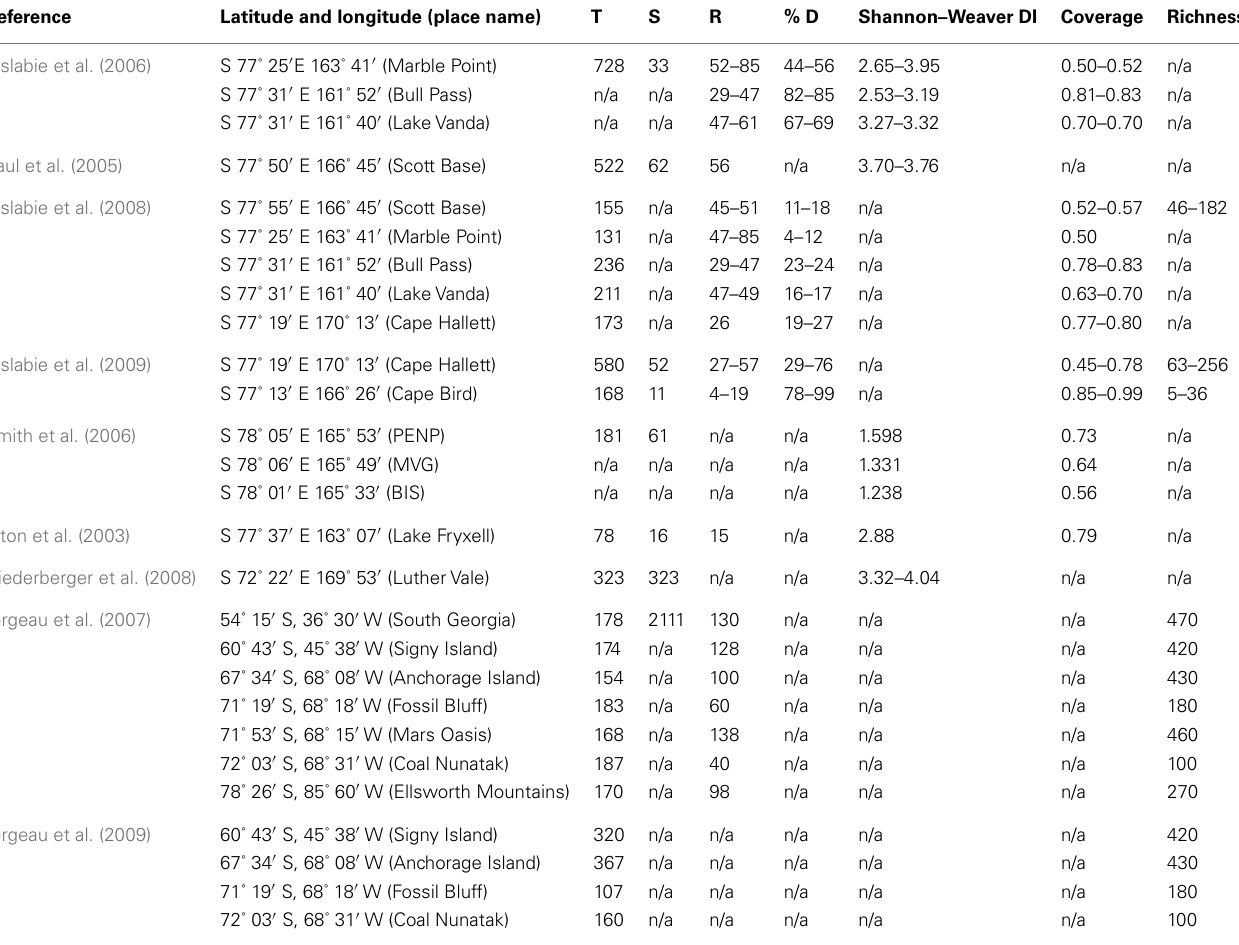
Table 1 | Summary data from a selection of previous studies ofAntarctic soil microbial